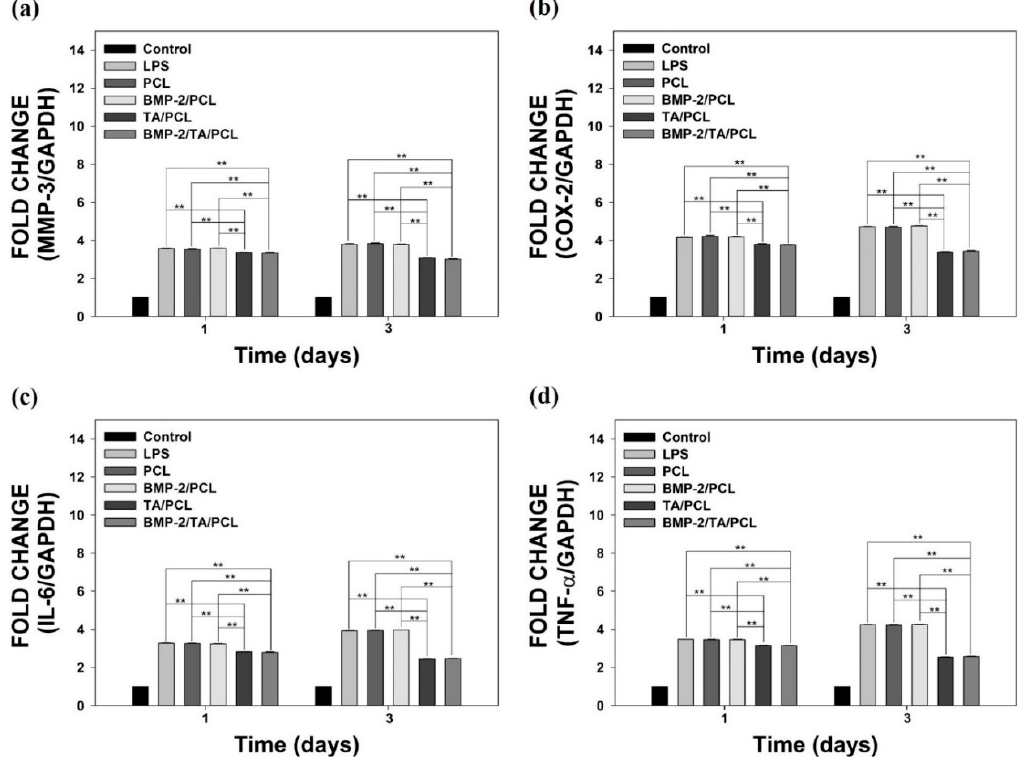
Figure 7. The relative mRNA expression levels of pro-inflammatory cytokines, including ( a ) matrix metalloproteinases-3 (MMP-3), ( b ) cyclooxygenase-2 (COX-2), ( c ) interleukin-6 (IL-6), and ( d ) tumor necrosis factor- α (TNF- α ) in lipopolysaccharide (LPS)-stimulated MC3T3-E1 cells grown on PCL, TA/PCL, BMP-2/PCL, and BMP-2/TA/PCL scaffolds on day 1 and day 3. Error bars represent the mean ± SD. ** p < 0.01.